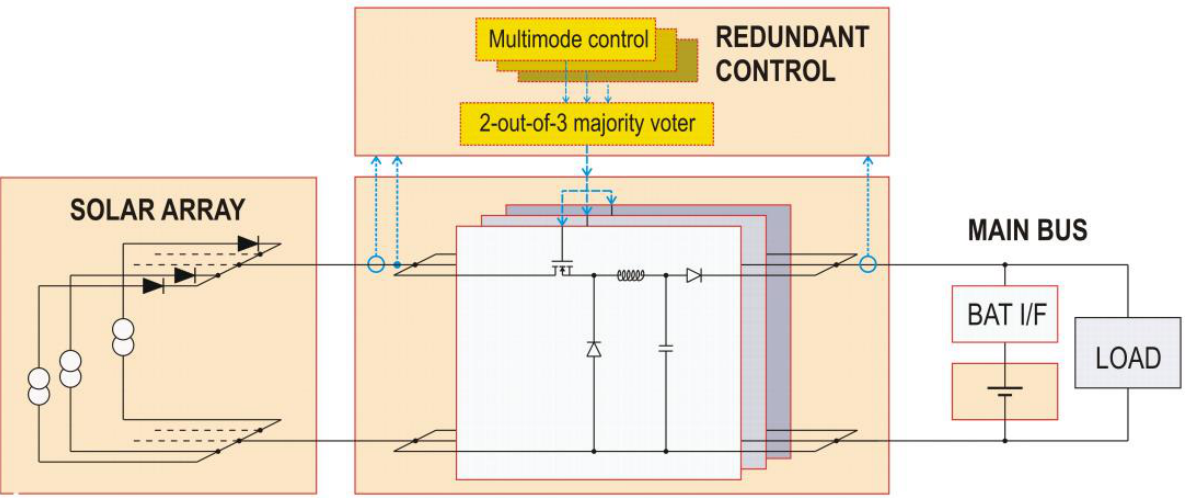
Figure 2. Power Module with the classic MPPT regulation for space solar arrays.